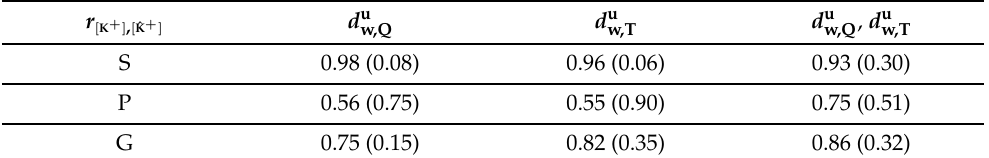
Table 4. Intra-patient Pearson correlation coefficient r between actual and estimated [ K + ] using uni- variable and multivariable estimators, with stage-specific (S), patient-specific (P) and global (G) approaches. Values are expressed as median (IQR).